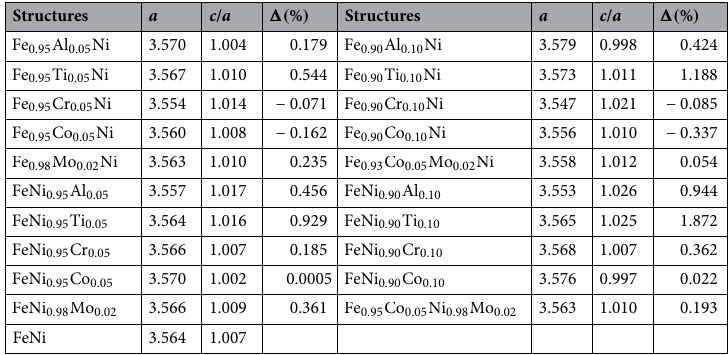
levels, shows rapid decrease of the transition temperature. The FeNi 1 − x Co x alloy on the other hand has small equilibrium volumes, but increased transition temperatures. In all alloy cases, except FeNi 1 − x Ti x , the maximum T od occurs around x = 0.05 . We expect the initial increase of T od for small values of x to be caused by the additional configurational entropy created by the dopant. Due to doping the configurational entropy of the ordered state is larger than zero. For small values of x , the proportional entropy gain of the ordered state should be larger than that of the random state. The entropy of the ordered state stabilizes the ordered configuration, as compared to the random state, which leads to the increasing T od for small values of x . Beyond x = 0.05 , T od starts decreasing, because the DFT total energy difference between ordered and random states starts to decrease significantly, as shown in Fig. 4. By inspection of the DFT energy differences